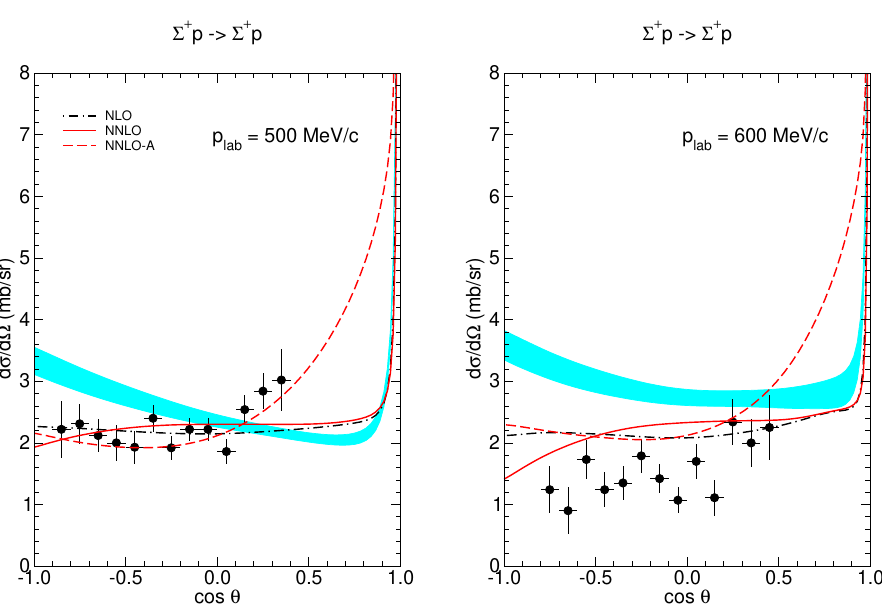
Figure 2. Di ff erential cross section for Σ + p . Same description of curves as in Fig. 1. Data are from Nanamura et al. [23] (momentum regions 440-550 MeV / c and 550-650 MeV /